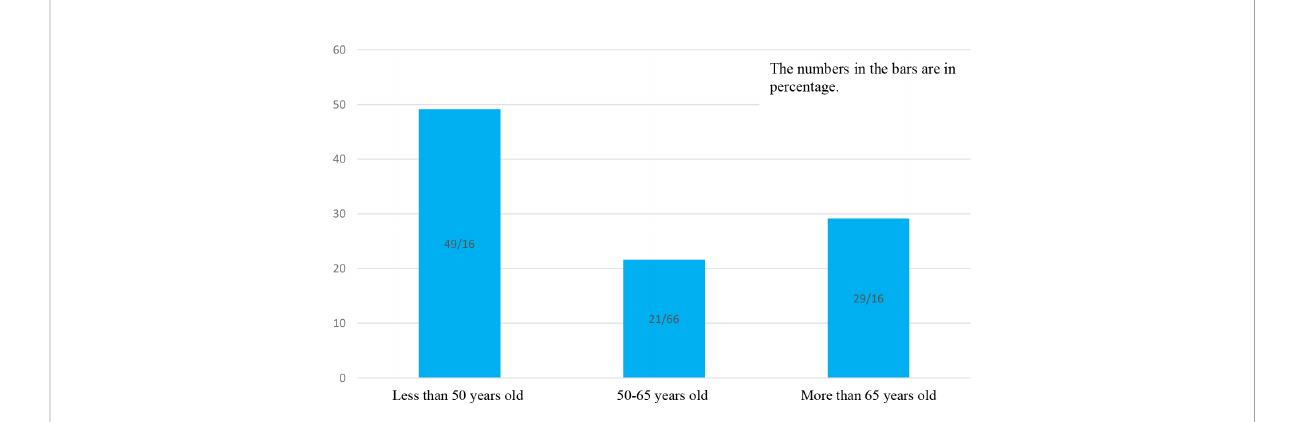
FIGURE 1 Age Distribution of COVID-19 Patients with Oral